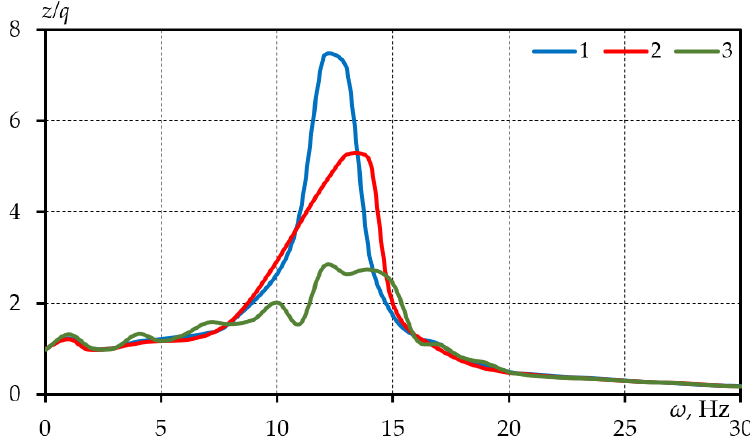
Figure 12. Frequency characteristic of the unsprung mass of the vehicle for the following road sur- face excitation amplitudes: 1 — 10 mm; 2 — 20 mm; 3 — 40 mm. excitation amplitudes: 1—10 mm; 2—20 mm; 3—40